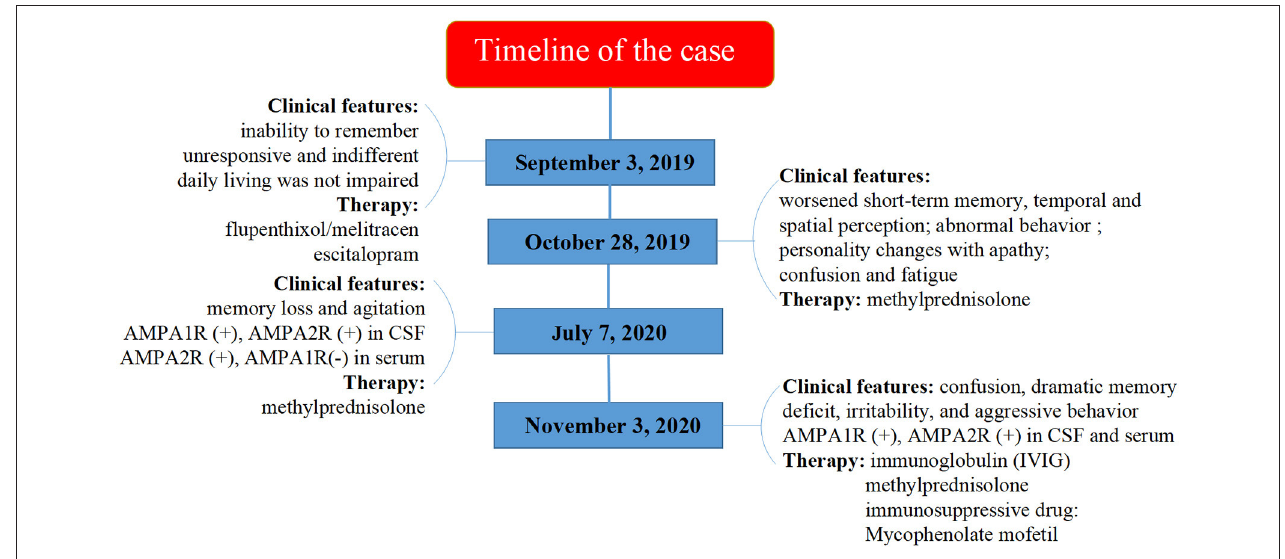
FIGURE 2 | Timeline of the